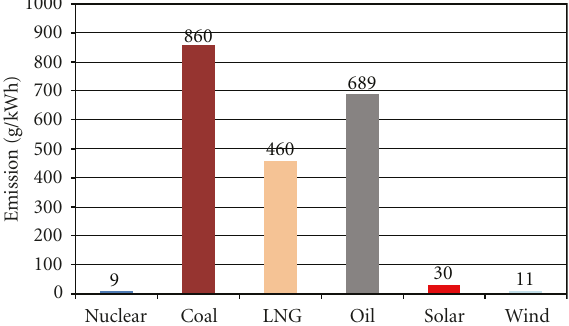
Figure 23: Generation costs of conventional thermal generators.